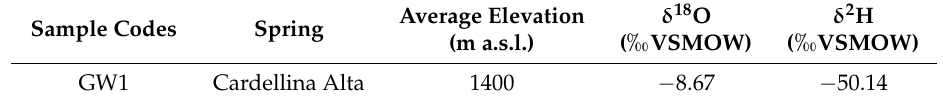
Figure 4. Average annual active evaluate using the Inverse Hydrogeological Balance Water Method ( a ) FSE; ( b ) interpolation. Table 3. Center of Mass Method—Average elevation of Cardellina Alta Spring (GW1).